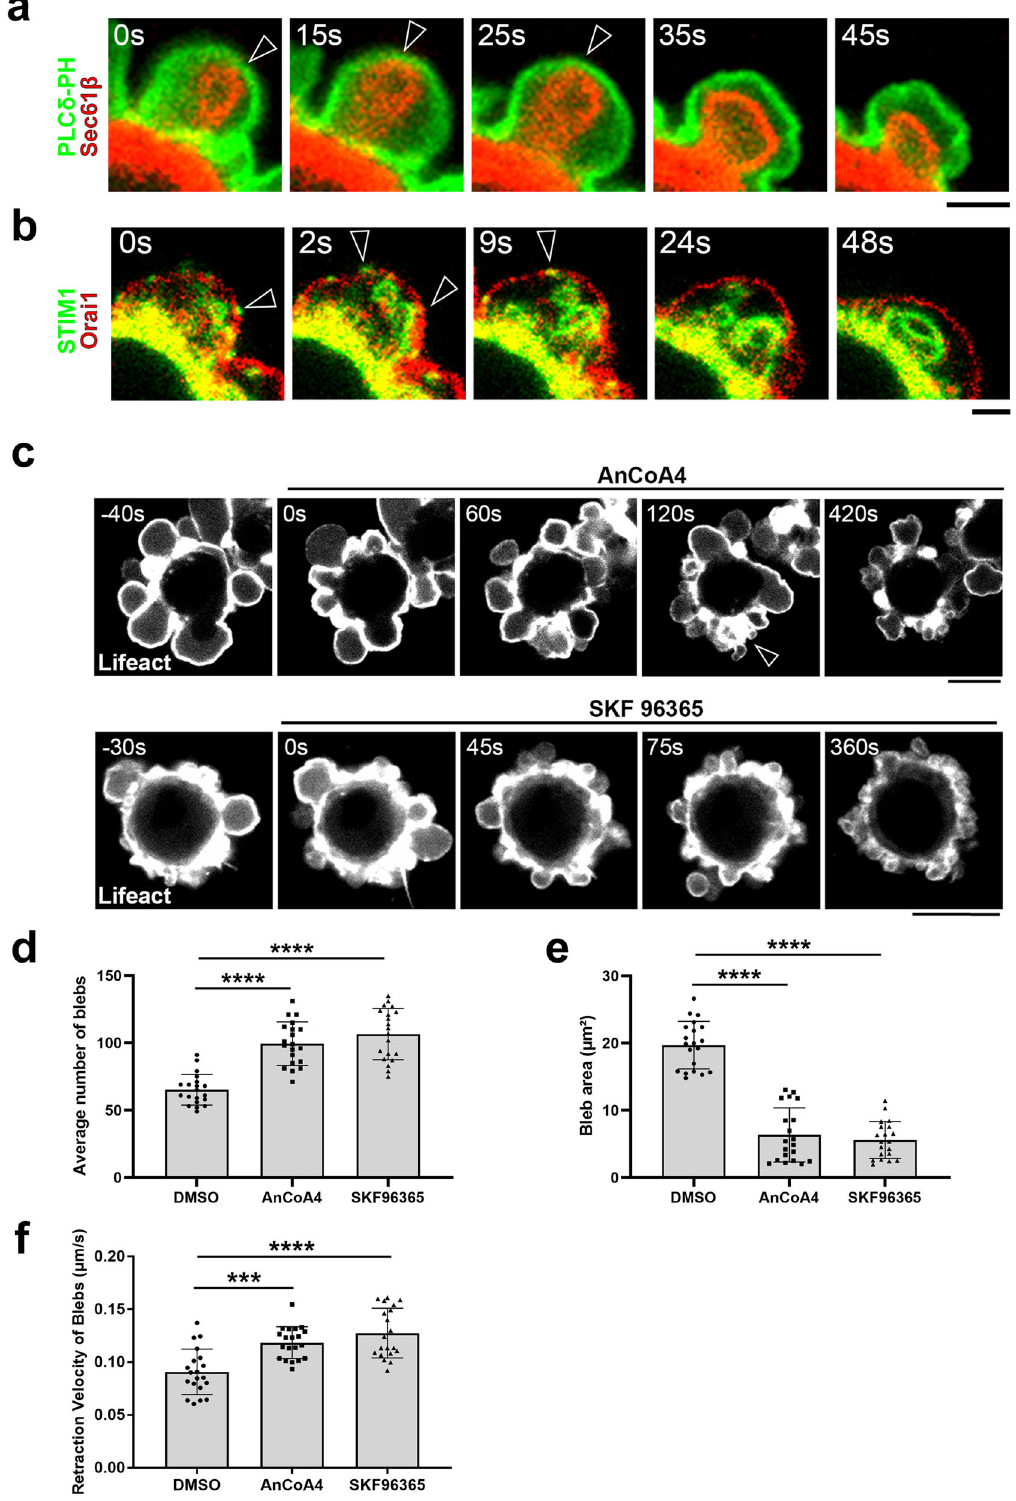
Fig. 4 The in fl ux of calcium ions via SOCE support expansion of membrane blebs. Membrane blebbing of DLD1 cells expressing either Sec61 β -mCherry and GFP-PLC δ -PH ( a , Supplementary Movie 5) or Orai1-mCherry and GFP-tagged STIM1 ( b ). Arrowheads show the ER-PM contact sites. Indicated times are relative to the fi rst image. Results shown are representative of three independent experiments. Scale bar, 2 μ m. c – f DLD1 cells expressing Lifeact-RFP were treated with the SOCE inhibitors AnCoA4 (50 µ M) and SKF96365 (10 µ M). c Representative images from three independent experiments. Indicated times are relative to drug treatment. Scale bar, 10 μ m. The number ( d , N = 20 cells), area ( e , N = 20 blebs) and retraction velocity ( f , N = 20 blebs) of membrane blebs in vehicle-treated (control) and drug-treated (4-bromo-A23187) DLD1 cells over 10 min from three independent experiments. Individual data points are plotted with the means ± SD. **** P < 0.0001 (One-way ANOVA with Tukey ’ s post-hoc multiple comparison test). Source data are provided as a Source Data fi